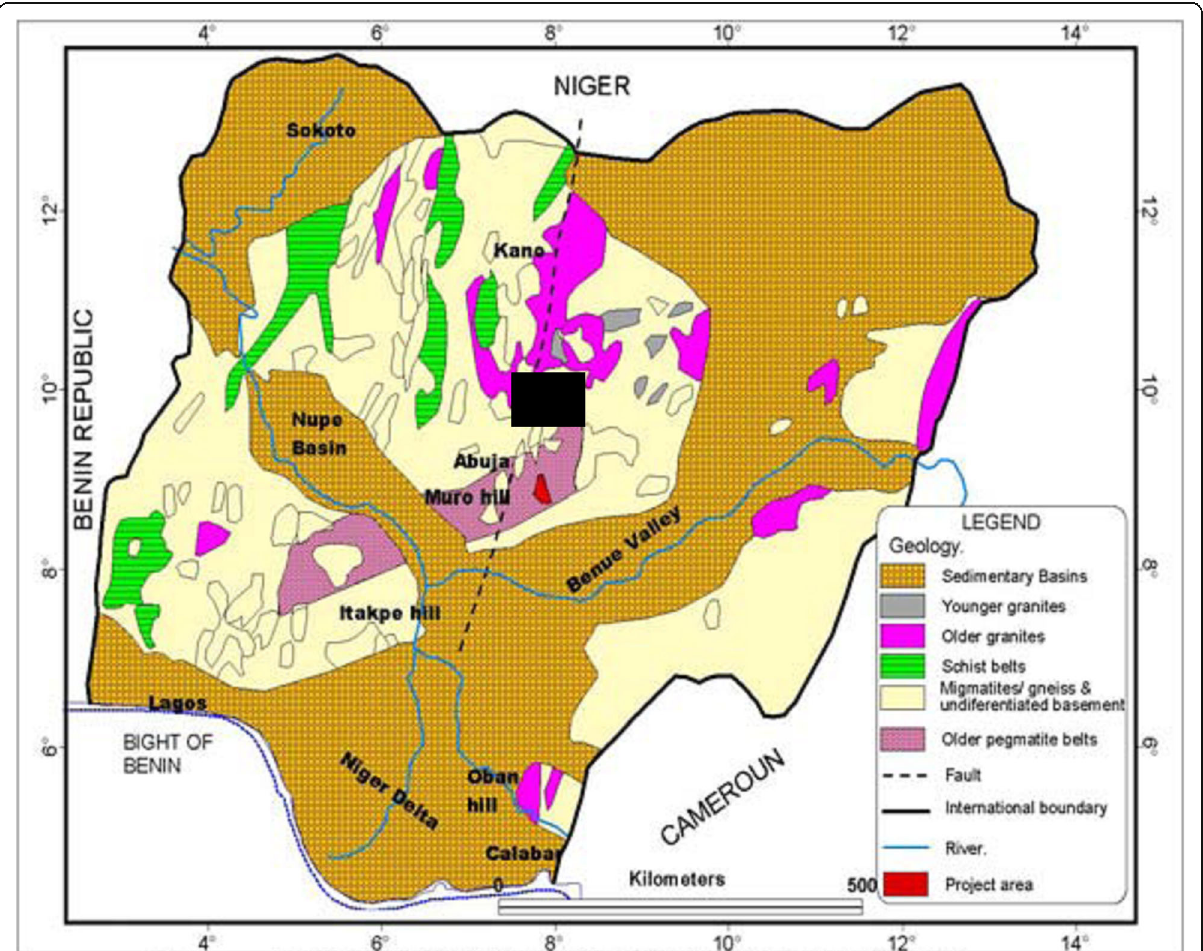
Fig. 1 Geologic map of Nigeria showing the rock type distributions (Olugbenga,